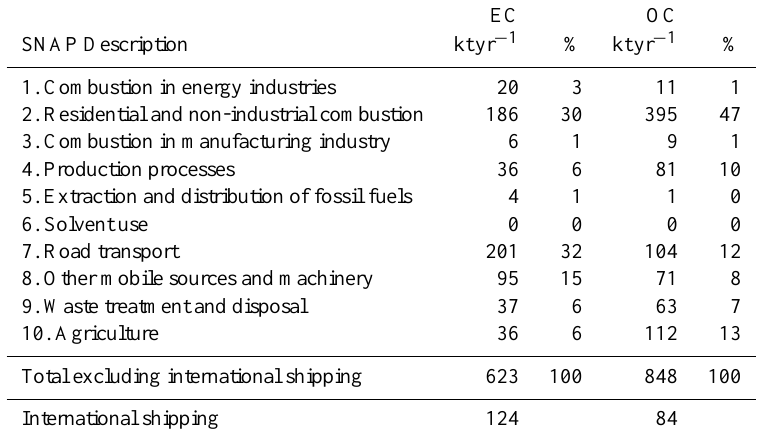
Table 1. Estimated EC and OC emissions ( < 2.5µm) for UNECE Europe in 2005 by source sector (ktonne(C)yr − 1 ). EC OC SNAP Description ktyr − 1 % ktyr − 1